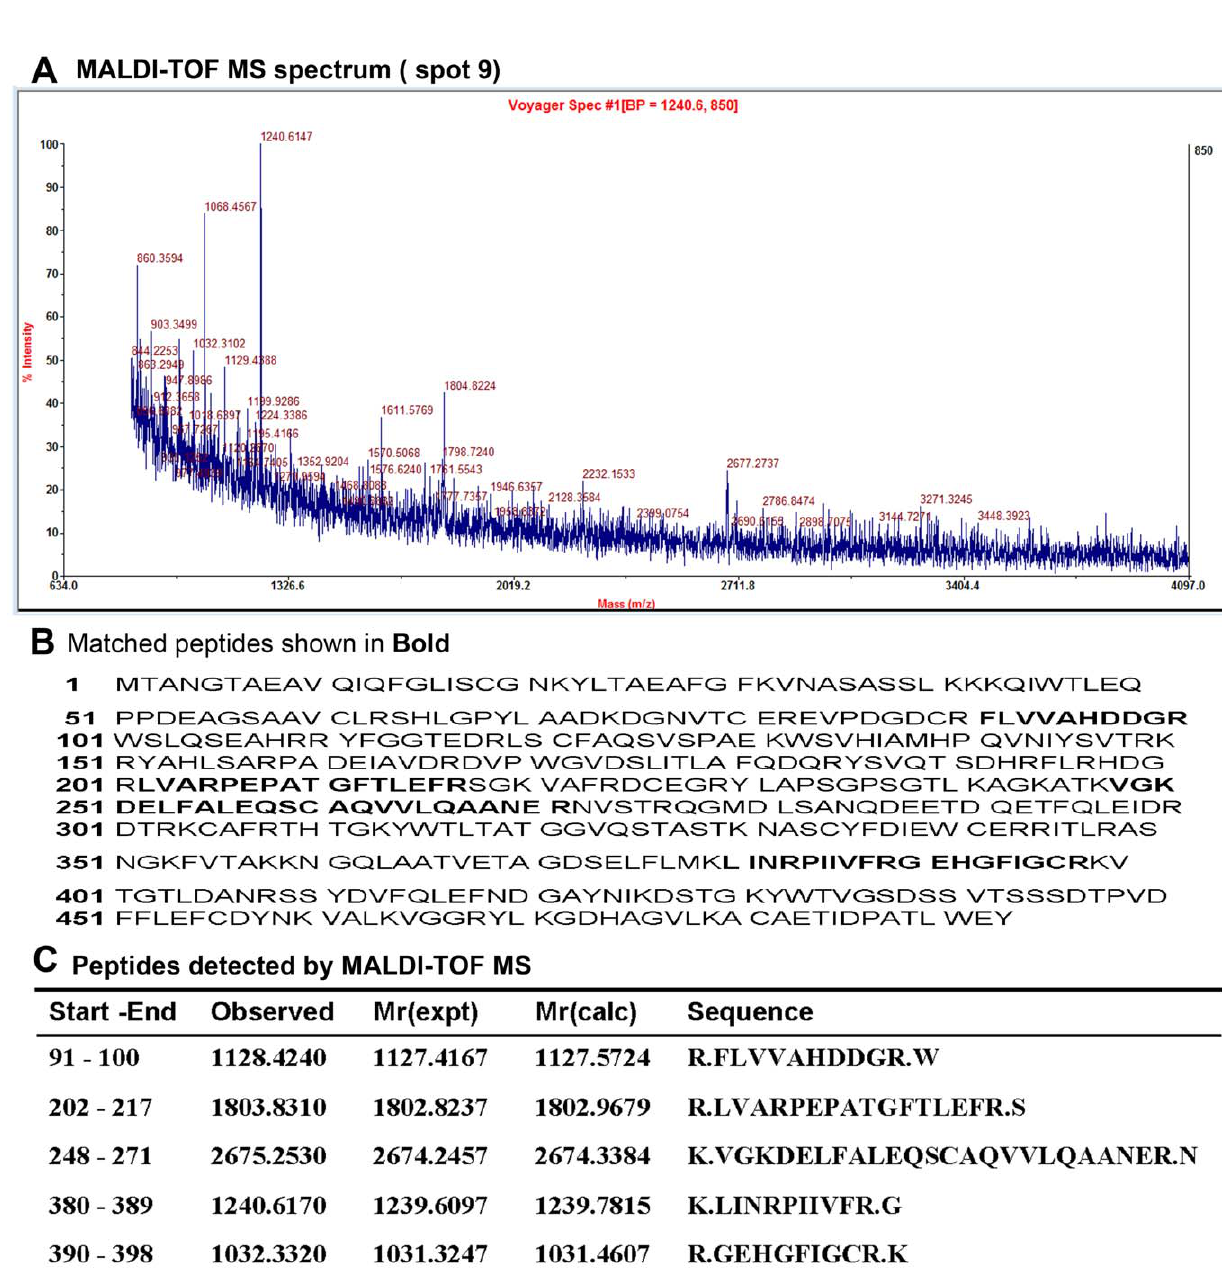
are also lower levels of other IFs.